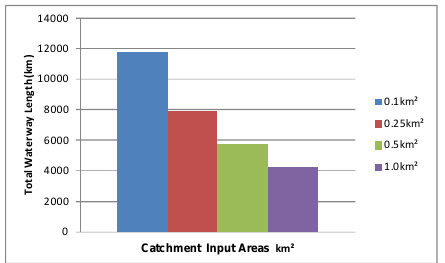
Figure 7. 20m DEM – Total Length of Waterways (Various Catchment Input Areas) Figure 8, Stream Ordered Waterways 20m DEM (various catchment input areas) shows stream ordered waterways in the Wivenhoe Catchment. It displays a consistency of higher lengths of waterways for each stream order, within the various test catchment input resolutions.